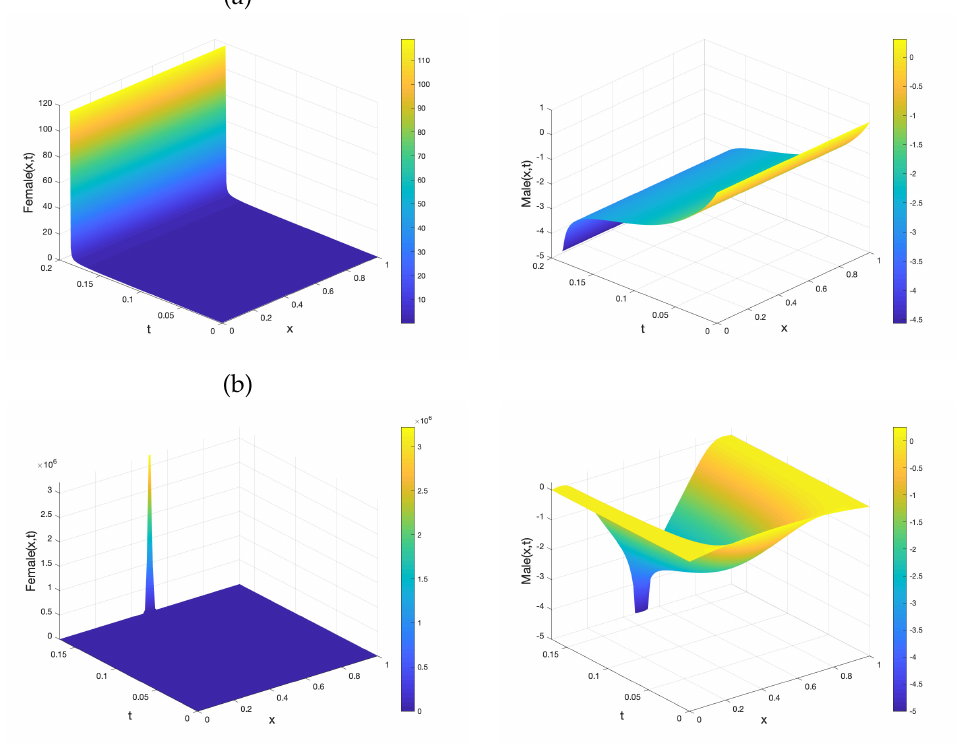
Figure 3. ( a ) Simulation for scaled system (6)–(8) with f ( x ,0 ) = m ( x ,0 ) = 0.3 and s ( x ,0 ) = 2.75 and Neumann boundary conditions. The increase in the initial amount of s results in finite time blow-up in f . This clearly shows blow-up of L 1 ( Ω ) norm is possible, as seen via Theorems 1 and 2. ( b ) Simulation with the initial conditions f ( x ,0 ) = m ( x ,0 ) = x ( 1 − x ) and s ( x ,0 ) = 4 s max x ( 1 − x ) , with s max = 3 and Dirichlet boundary conditions. The increase in the maximum number of s results in finite time blow-up in f . Simulation uses D = 0.01, γ = 0 and ρ =